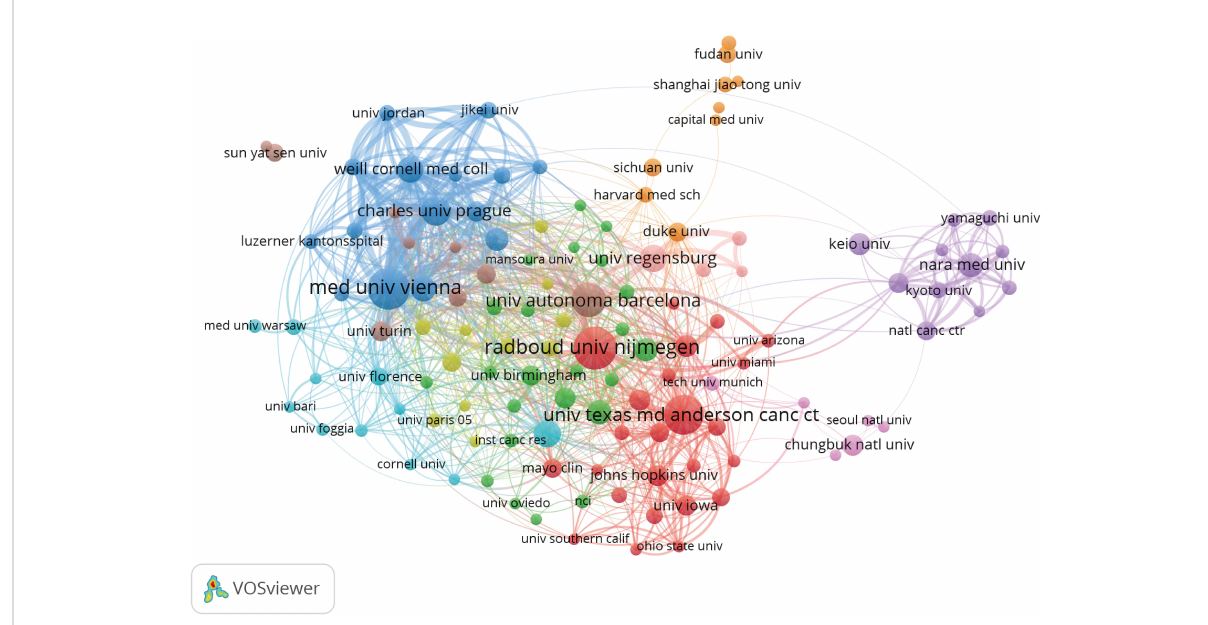
FIGURE 5 Co-occurrence map of Institutions. The size of the nodes represents the number of articles; the thickness of the curve represents the strength of the collaboration; the colors represent different collaboration